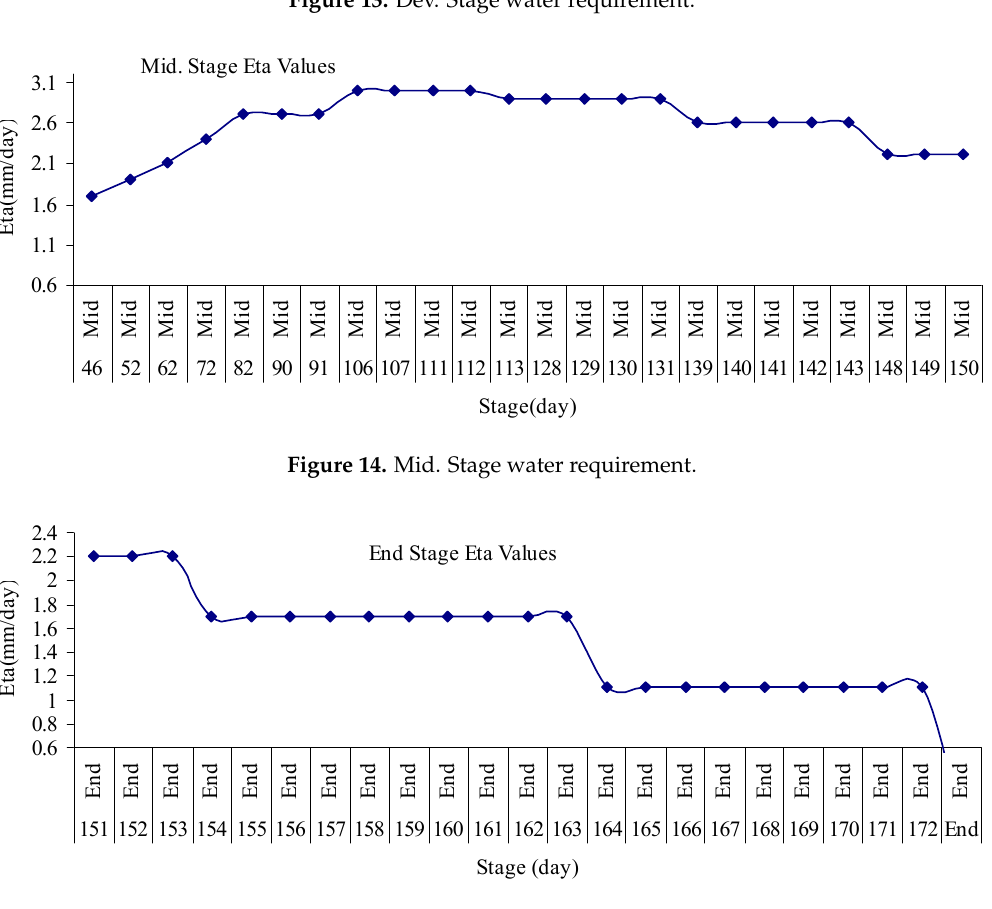
Figure 15. End stage water requirement.